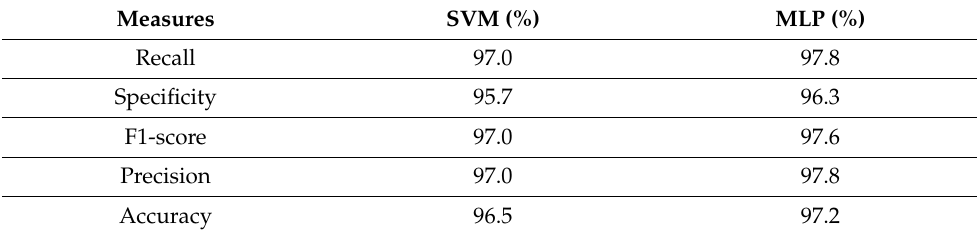
Table 4. Performance assessment for proposed classifiers with PSO.